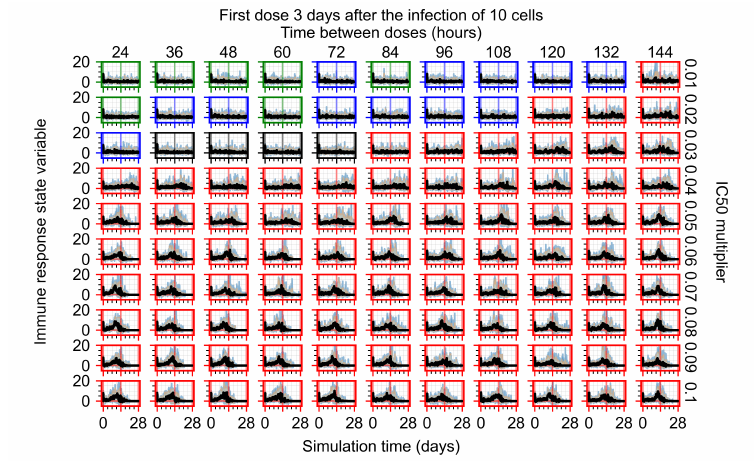
Figure A65. Immune response state variable number. Positive values correspond to an inflammatory state, and negative to an anti-inflammatory state.